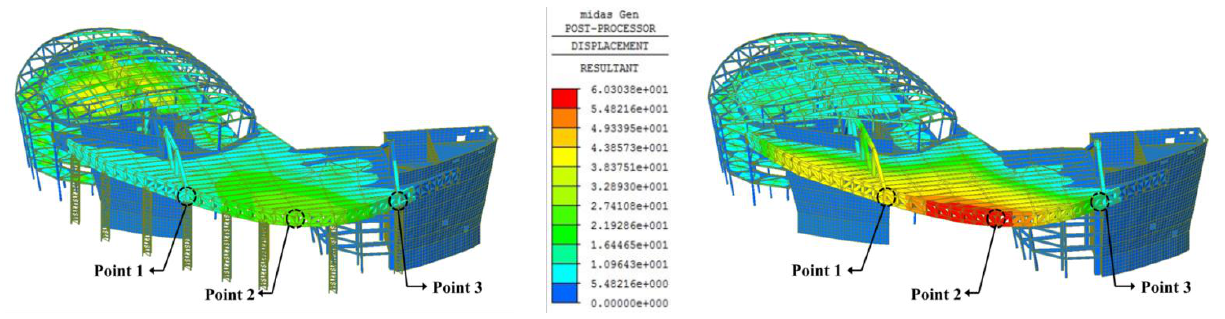
Figure 12. Calculated displacement of building: ( a ) before and ( b ) after bent